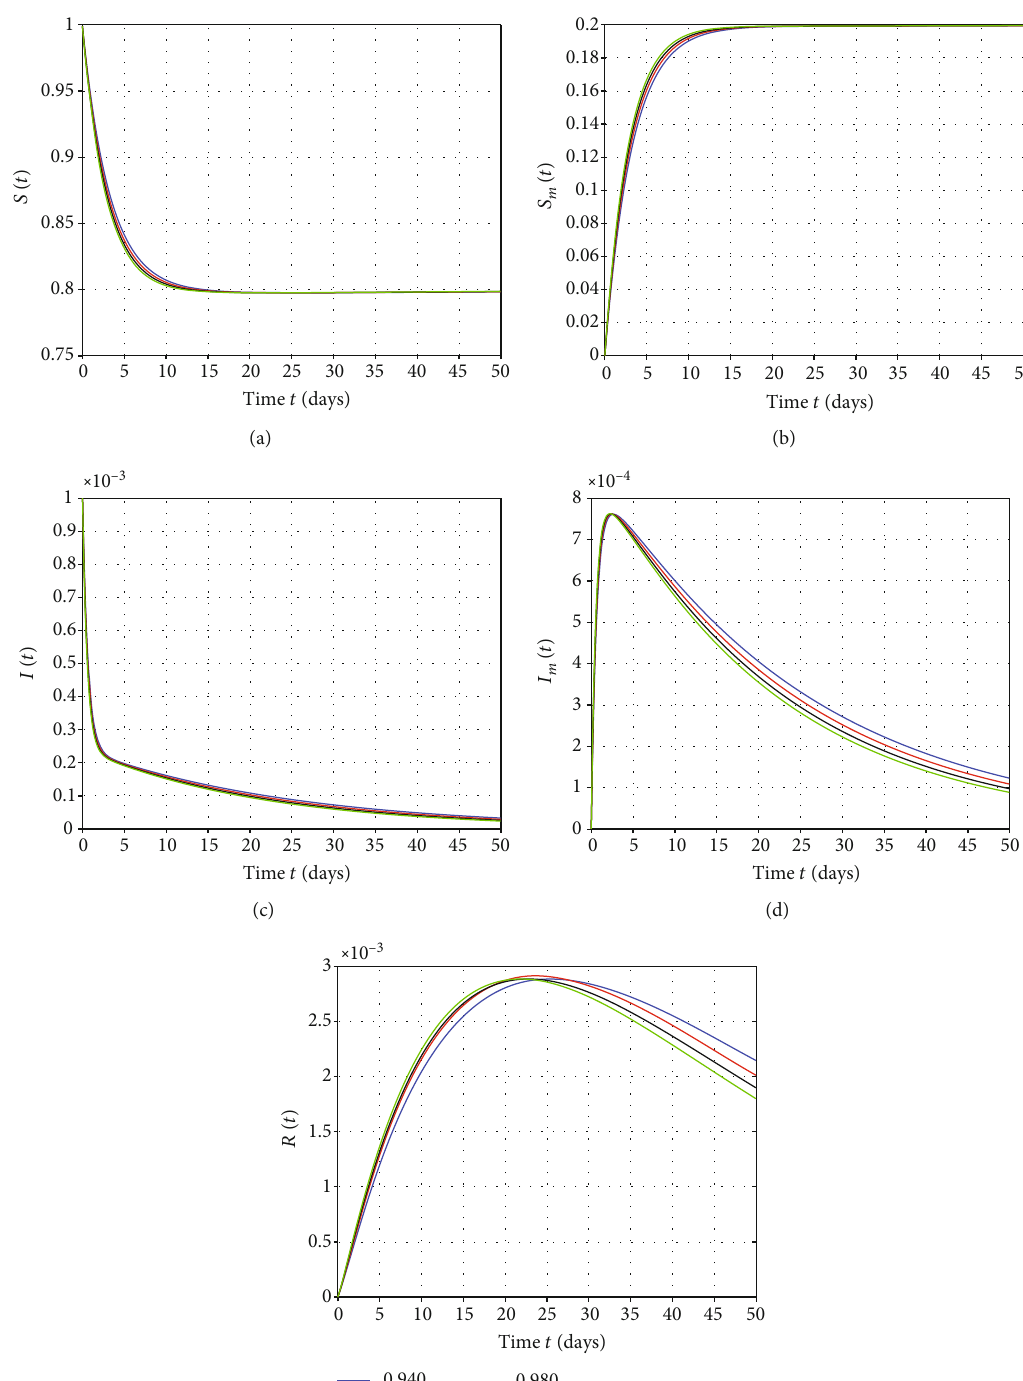
Figure 1: Numerical solution of (10) for κ = 0 : 1 and di ff erent values of ϵ fractional